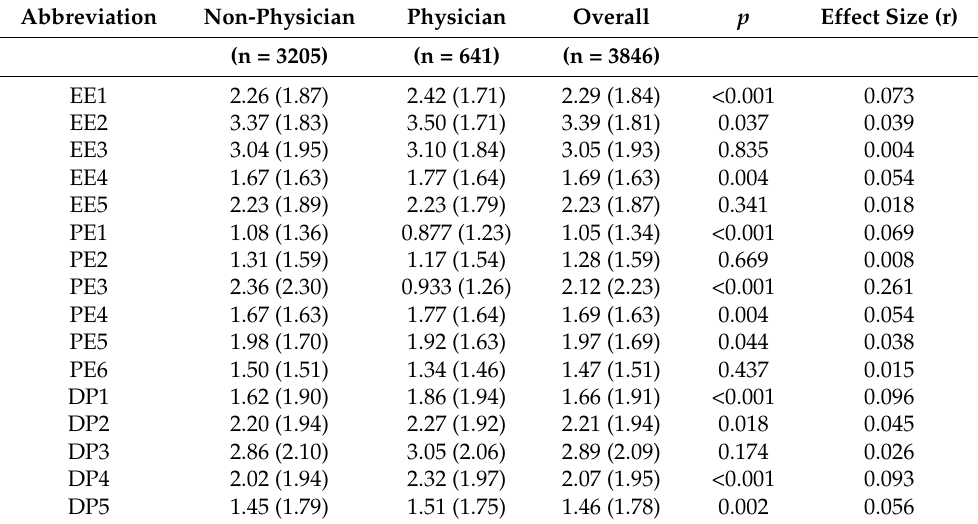
Table 2. Differences in burnout symptoms of physicians and non-physicians.